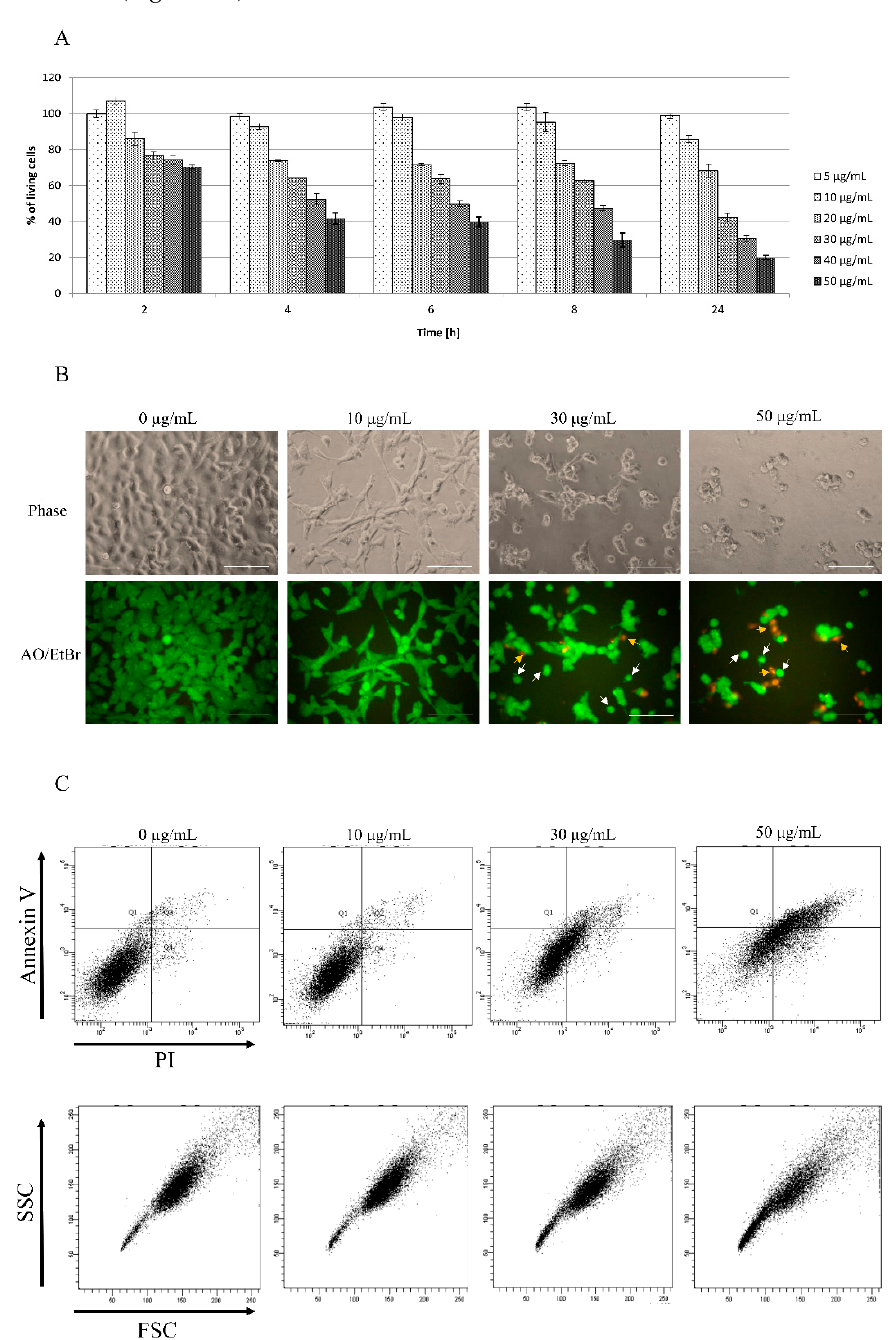
Figure 1. Kinetics of star polymer action on HT-1080 cells. ( A ) The cytotoxicity assay of the tested star polymer. The assay was performed with HT-1080 cells. The results are presented as a % of cells surviving in the presence of the star polymer in the range of concentrations (5–50 µ g/mL). ( B ) HT-1080 cells after 6 h of treatment with star polymer at indicated concentrations were seen under light microscope (upper panel) and under fluorescence microscope (lower panel) following nuclear staining with acridine orange/ethidium bromide (AO/EtBr) double staining. Cells with features of early apoptosis are indicated by white arrows and late apoptosis by yellow arrows. Scale bars represent 100 µ m. ( C ) Flow cytometry analysis of cell death type in HT-1080 cells treated with star polymer after 6 h using annexin V and PI staining.